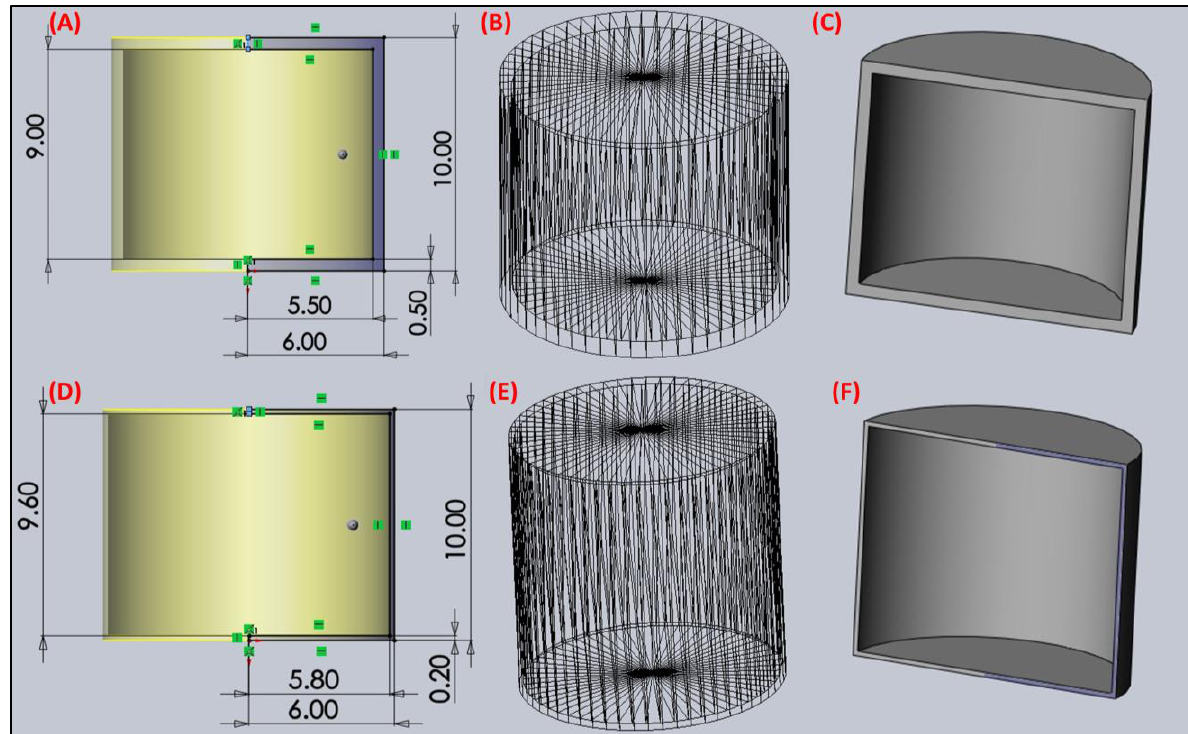
Figure 7. 3D designs developed for printing the hollow container system: ( A ) dimensional measure- ments, ( B ) .stl file triangle count and ( C ) cross-sectional view for the print with 1 mm wall thickness, ( D ) dimensional measurements, ( E ) .stl file triangle count, and ( F ) cross-sectional view for the print with 0.4 mm wall thickness.